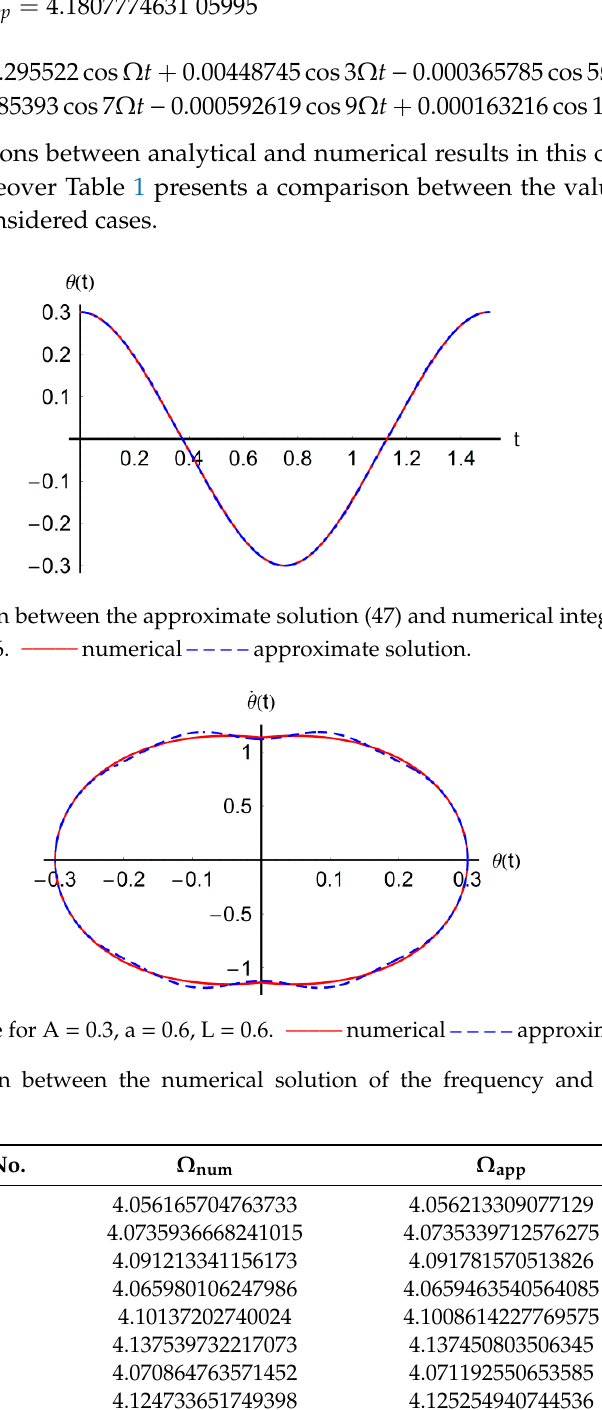
Figure 20. Comparison between the approximate solution (50) and numerical integration results for